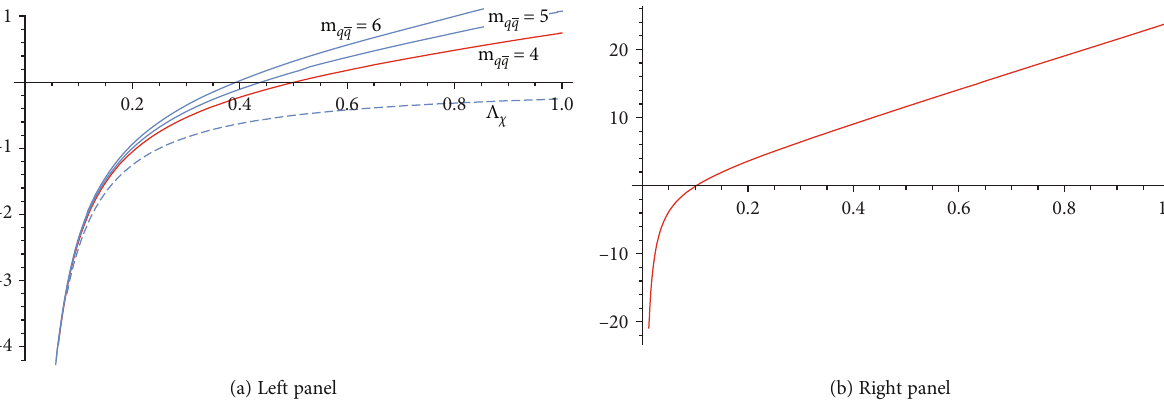
Figure 5: A graph of the Cornell-like potential V